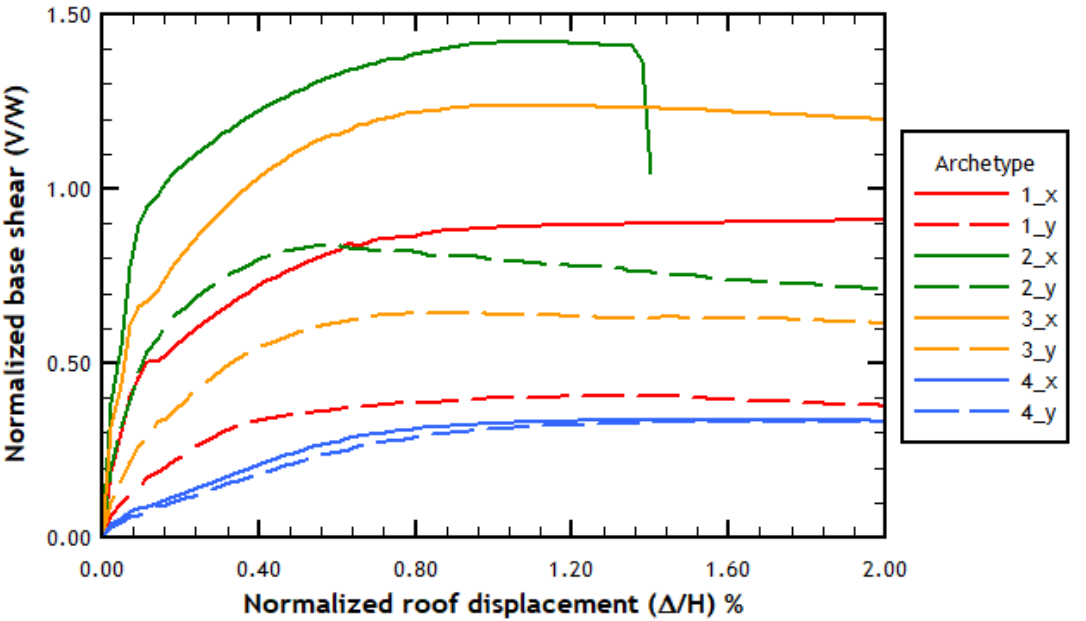
Figure 10. Capacity curves obtained from conventional pushover